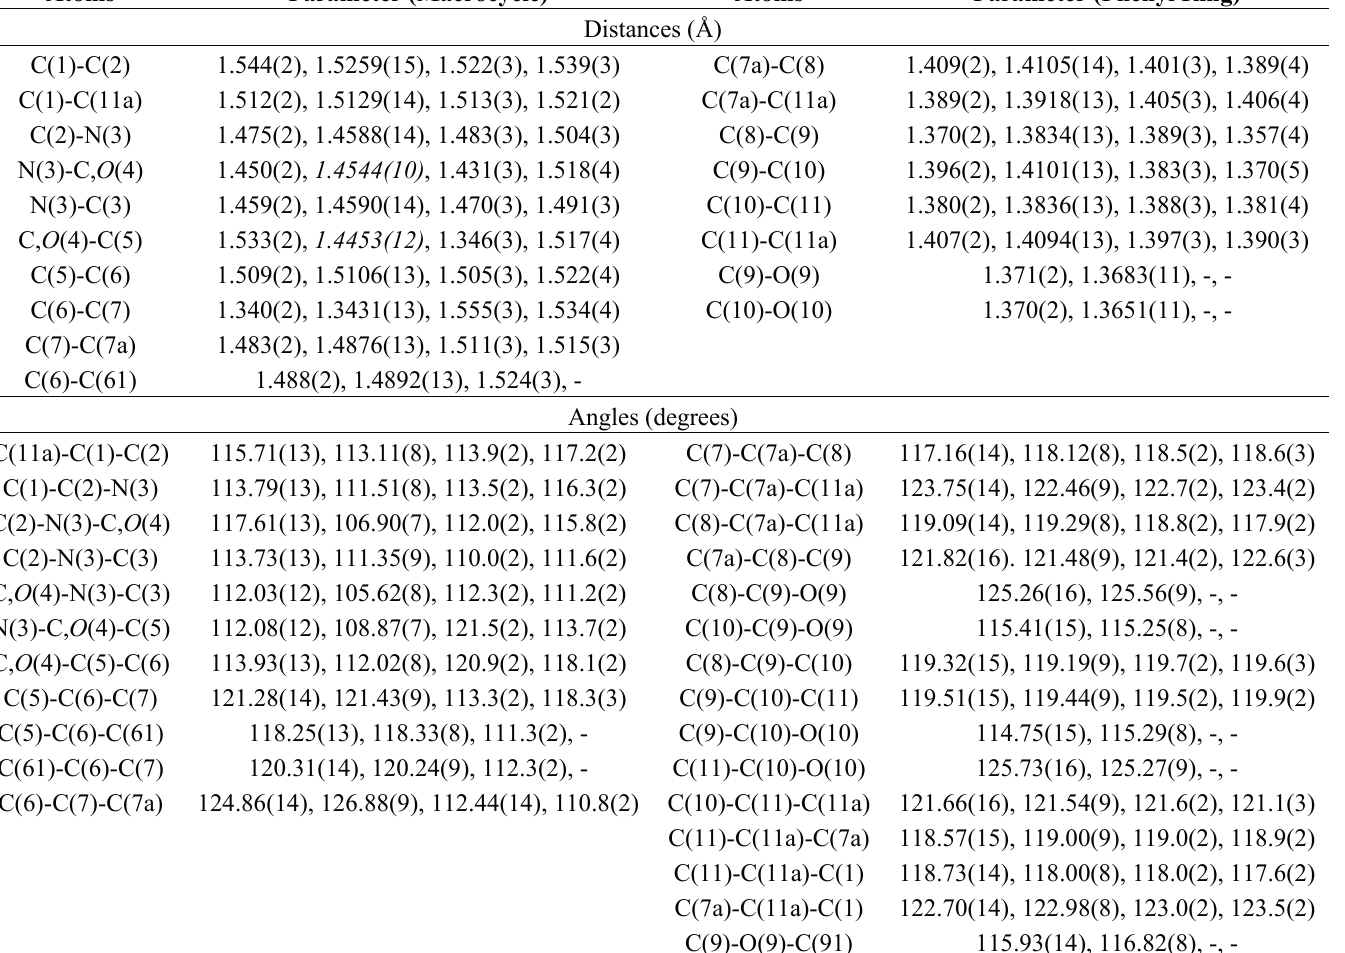
Table 2. Selected geometries ( E - 1 , 2 ; counterpart values for AYEKOF (100 K) [26], SELXUC (293 K) [27] are also given.) *